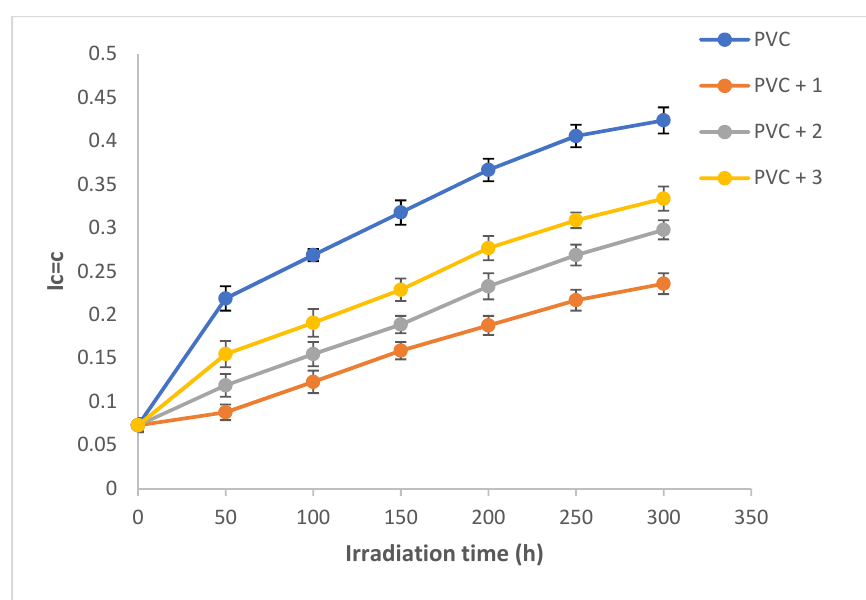
Figure 3. Irradiation time against I C=C index alternations of PVC.